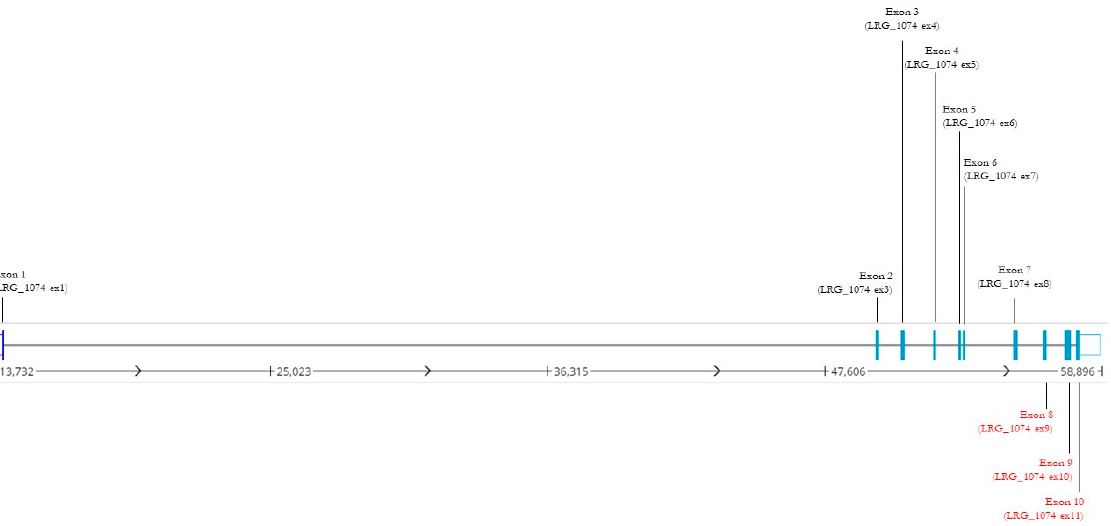
Figure 1 . Linear structure of GCK gene . For each GCK exon, the figure shows the LGR_1074 specific numbering and the NM_000162.5 (LGR_1074t1) transcript specific numbering. Exons involved in the novel rearrangement are reported in red (ftp.ebi.ac.uk/pub/databases/lrgex/LRG_1074.xml, accessed on 4 November